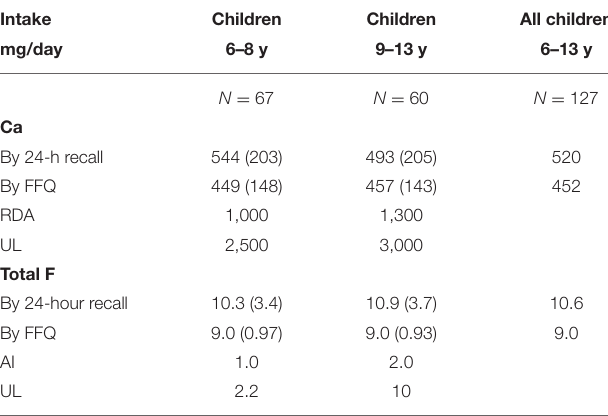
TABLE 4 | Mean (SD) dietary calcium (Ca) and total fluoride (F) intakes of school children 6–13 years, mean (SD) in comparison with dietary standards, Halaba Zone selected kebele, SNNPR, Ethiopia